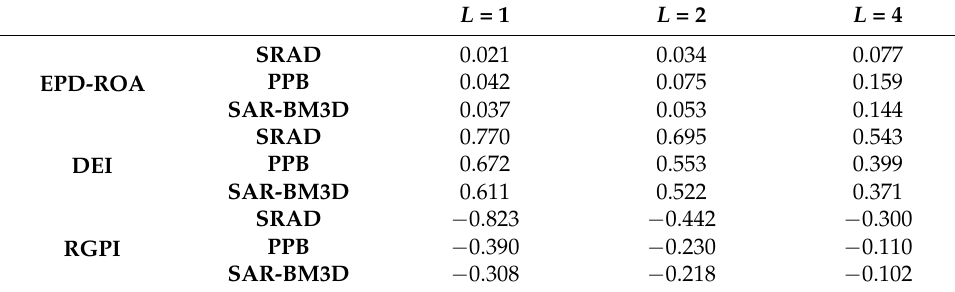
Figure 4. Range profiles of the building obtained by the three filters (red) compared with the clean reference (black). ( a )The SRAD filter. ( b ) The PPB filter. ( c ) The SAR-BM3D filter. Table 2. EPC assessment results for the simulated data.